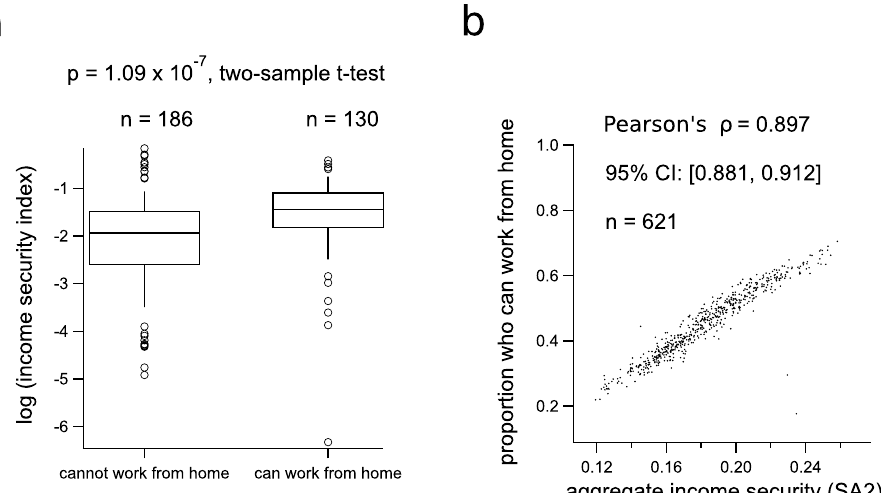
Figure 3. Relationship between income security and the ability to work from home. Box plots in ( a ) compare the distributions of log-transformed income security, grouped by the ability to work from home for each of 321 occupations classified by 4-digit ANZSCO codes. The distributions in ( a ) are computed from the HILDA survey, 2018. The scatter plot in ( b ) demonstrates the correlation between average income security for each SA2 region, and the corresponding average proportion of individuals who can work from home, computed from the occupation distribution of each SA2 in the Greater Sydney and Greater Melbourne regions released in the 2016 ABS Census. [Note: the log-transformed income security data in ( a ) omits 24 occupations that had a value of 0 for income security (no securely employed HILDA respondents), of these, 2 were grouped into the “can work from home” category and 22 into the “cannot work from home”